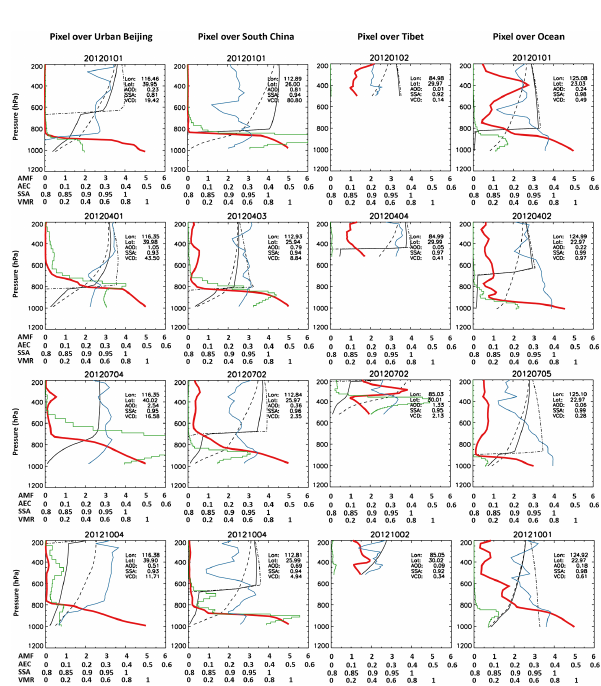
Figure A1. Vertical profiles of NO 2 volume mixing ratios (VMRs, thick red lines), aerosol extinction coefficients (AECs, green lines), SSA (blue lines), AMFs (black lines), clear-sky AMFs (black dashed lines), and cloudy-sky AMFs (black dotted dashed lines) at the beginning of January, April, July and October at represen- tative pixels in four areas: urban Beijing, southern China, Tibet, and the oceans. The VMRs are normalized to the maximum VMR of the vertical profile. Embedded in each panel are longitude, lati- tude, AOD, SSA and retrieved NO 2 VCDs (in 10 15 cm − 2 ) . Here, “20120101” in the title of the top-left panel means 1 January 2012, and so on.